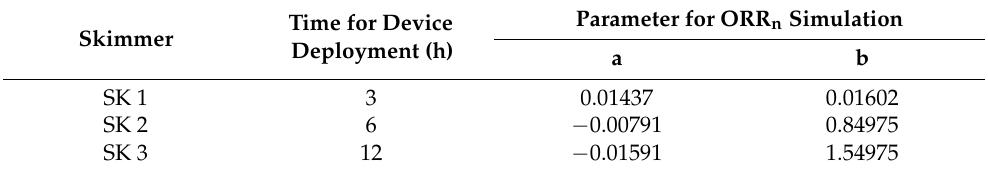
Table 5. Time for device deployment and parameters for ORRn